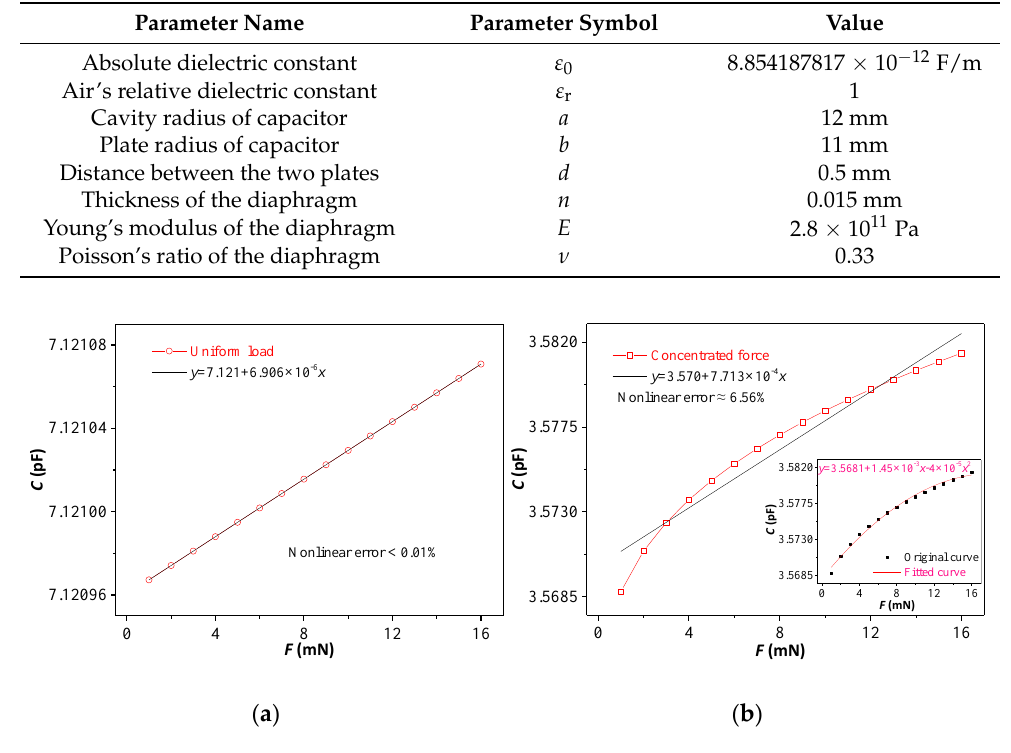
Figure 3. Calculation results by MATLAB ( a ) Thin circular plate model with uniform load. ( b ) Thin circular plate model with concentrated force. Table 1. Sensor’s structural parameters used for MATLAB calculation and COMSOL simulation.